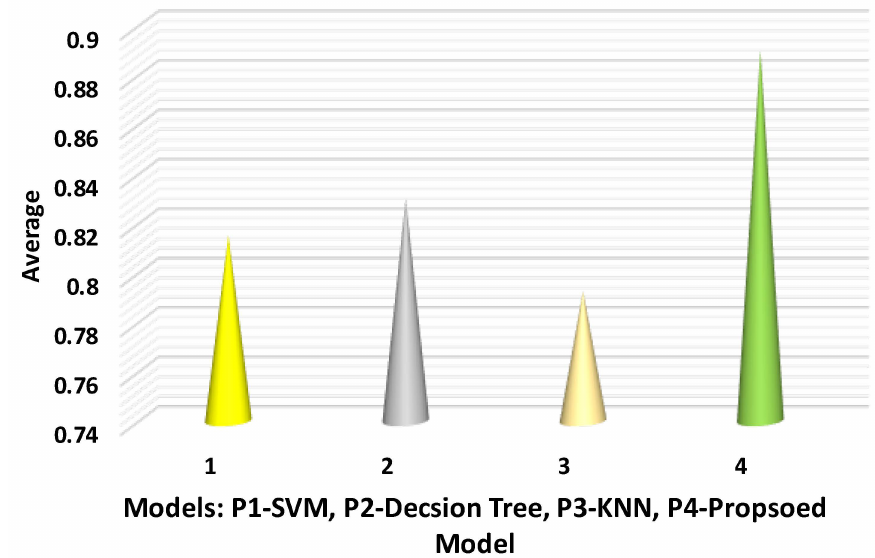
Figure 8. Specificity